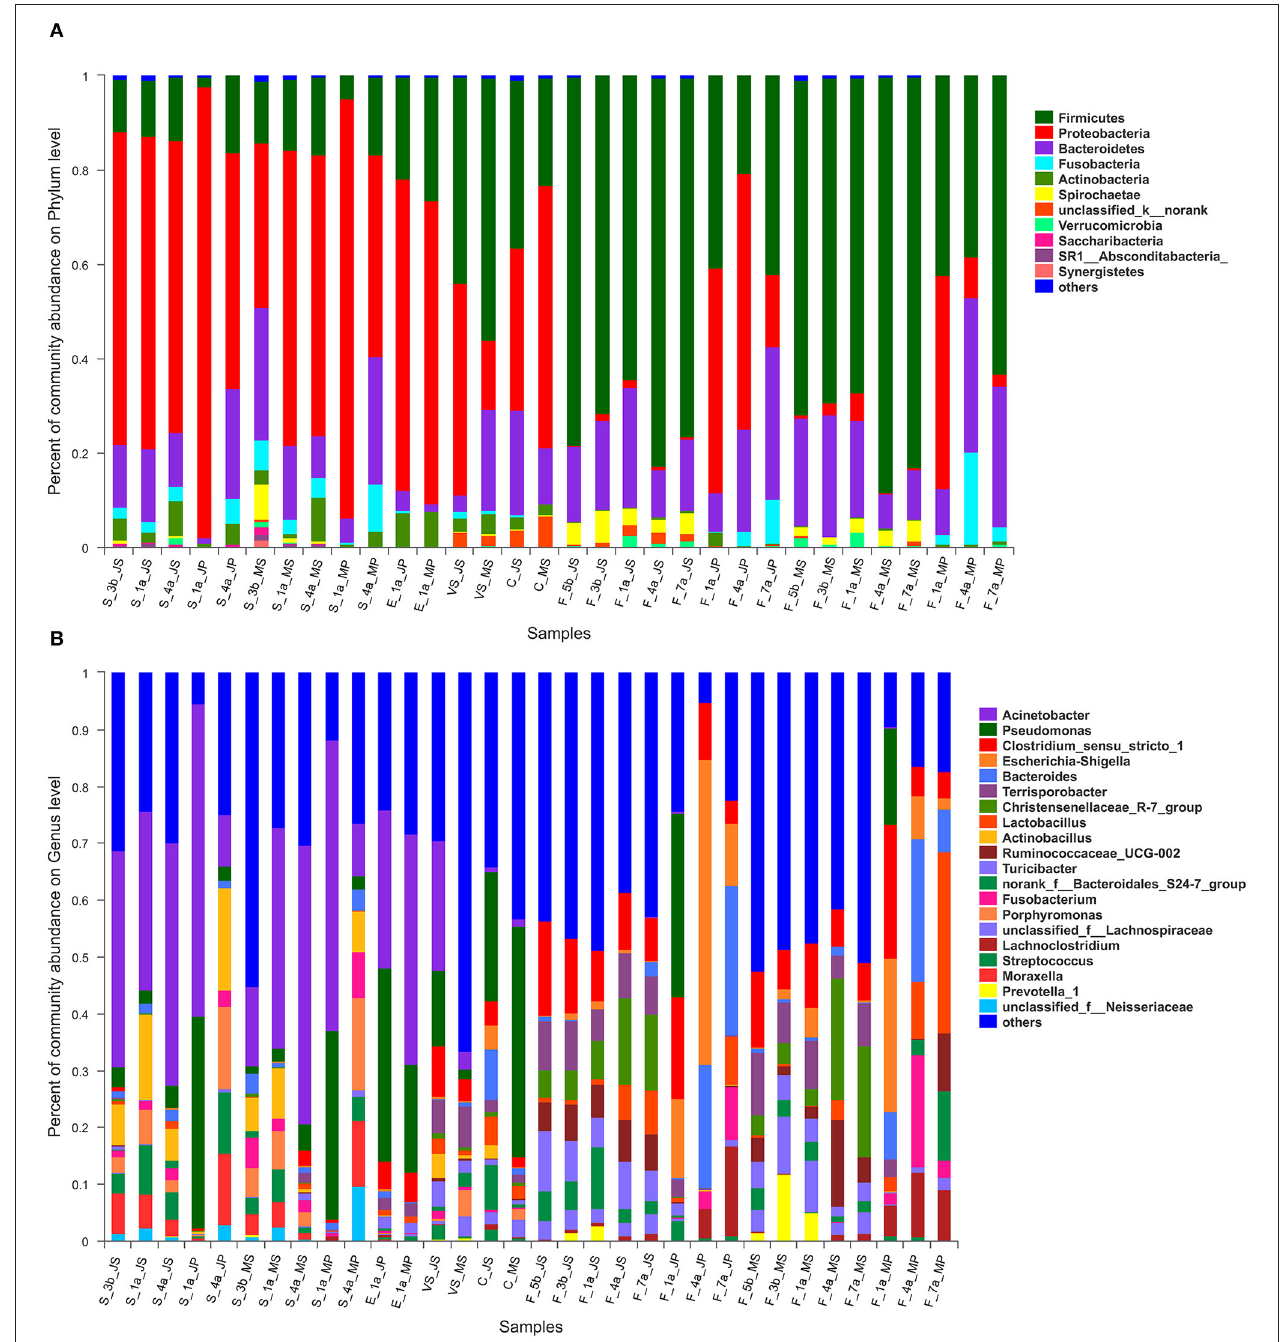
FIGURE 4 | The microbiota composition of Mashen pig and Jinfen White pig. (A) The microbiota composition of Mashen pig and Jinfen White pig at the phylum level. (B) The microbiota composition of Mashen pig and Jinfen White pig at genera level.